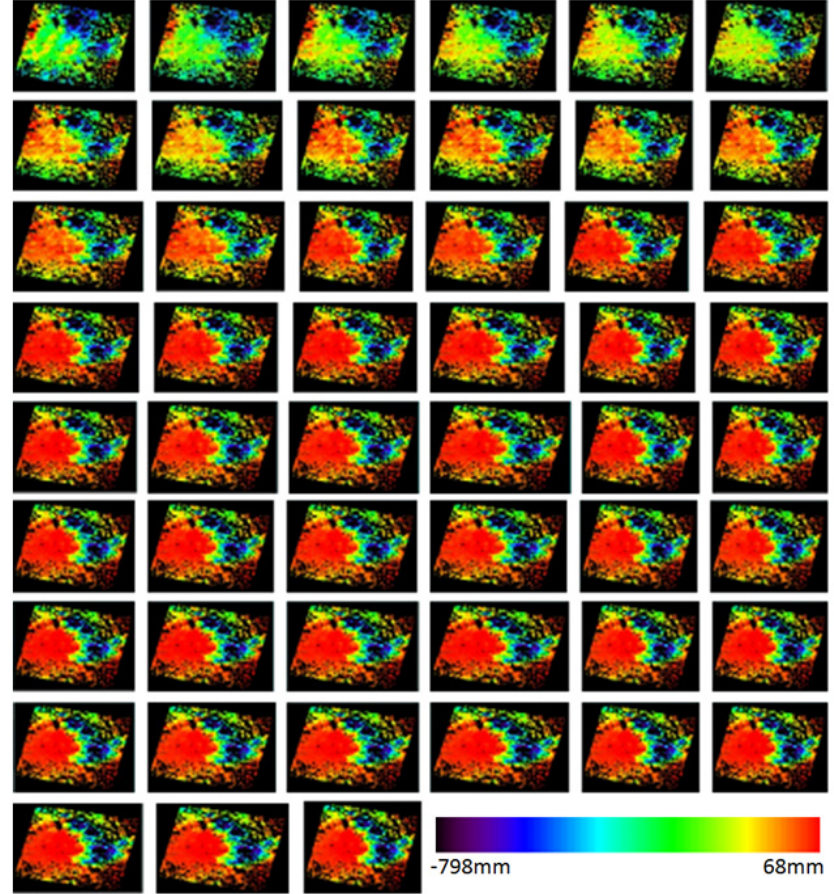
Figure 9. Estimated accumulated displacement (LOS direction) from June 2003 to August